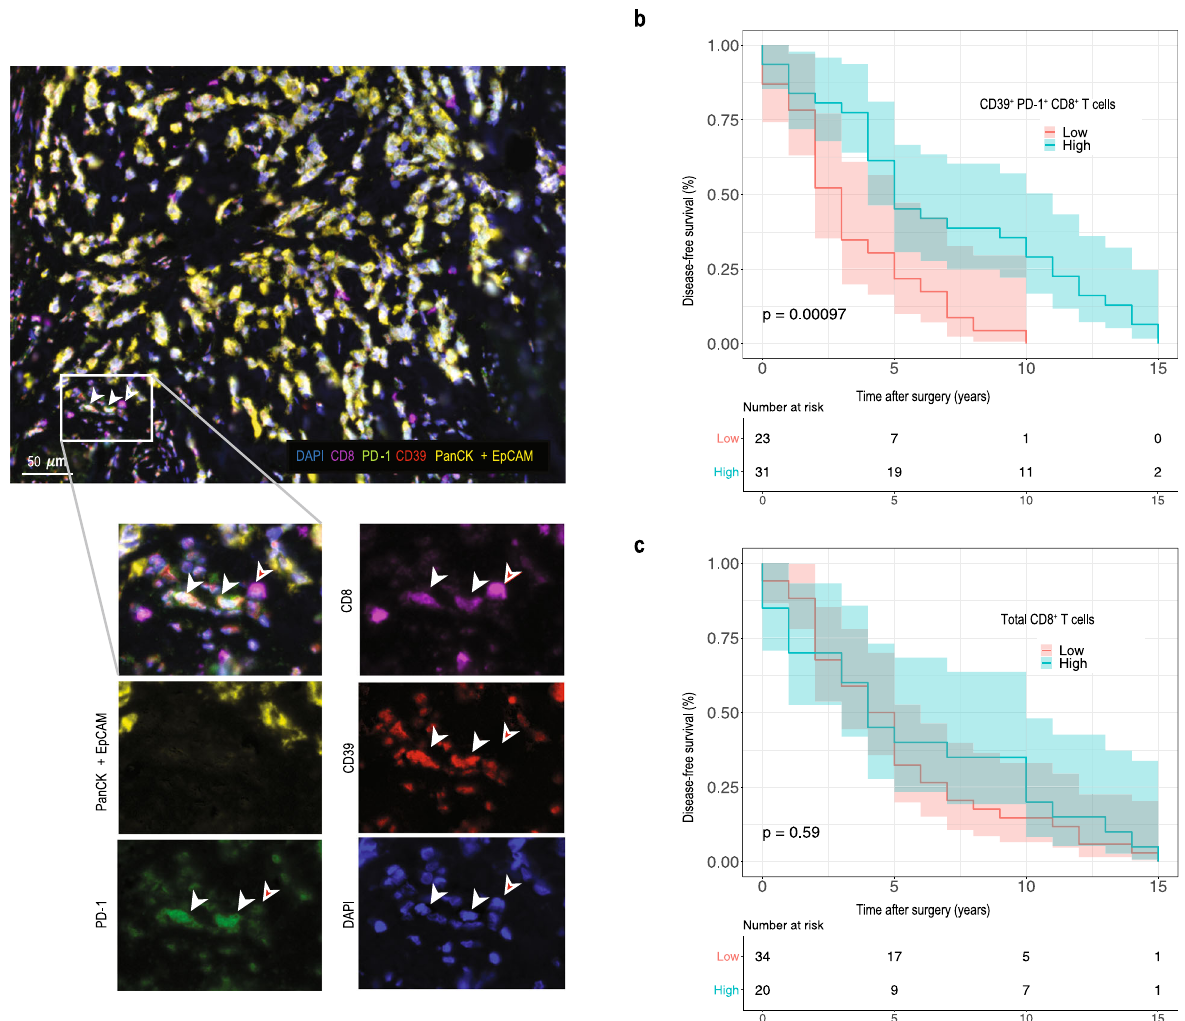
Fig. 6 High density of intra-tumoral CD39 + PD-1 + CD8 + but not total CD8 + T cells correlates with disease-free survival in human breast cancer. a Representative images of 5-color multiplex immuno fl uorescence on human breast cancer. Staining shows epithelial cells (PanCK + EpCAM, yellow), CD8 + T cells (CD8, magenta), PD-1 (green), CD39 (red) and nuclear staining (DAPI, blue). Scale bar is 50 µ m. b Disease-free survival of 54 patients with high or low number of intra-tumoral CD39 + PD-1 + CD8 + T cells . c Disease-free survival of 54 patients with high or low number of intra-tumoral CD8 + T cells. The threshold for separating patients with high and low CD39 + PD-1 + CD8 + T cell densities was de fi ned using ROC curve analysis. Survival was compared for patients with high and low density of cells to be compared as indicated for the individual graphs by Kaplan – Meier curves. Con fi dence intervals are indicated as shaded areas surrounding survival curves. Signi fi cance was calculated by log-rank test. Patient numbers at risk are displayed for each 15 years of Only cells of early passages were used for experiments. Cells were regularly tested negative for mycoplasma by PCR analysis. Cells were also tested negative for 18 additional mouse pathogens by PCR (IMPACT II Test, IDEXX Bioanalytics).